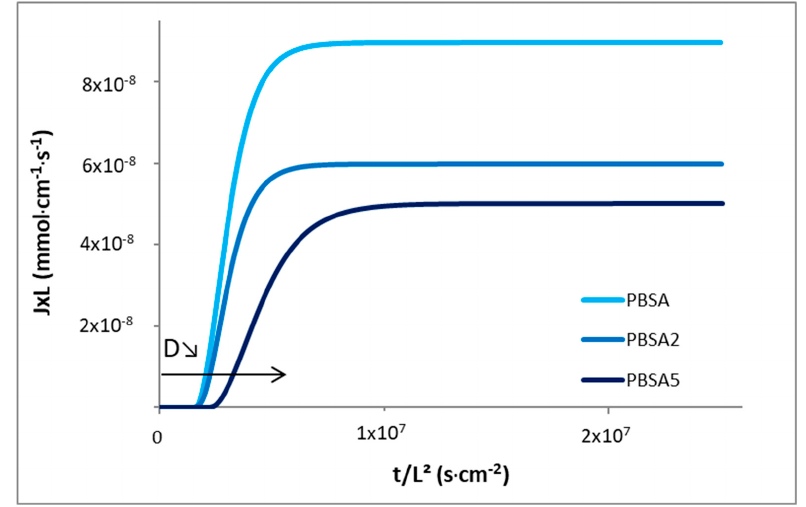
Figure 4. Reduced water permeation curves for the neat PBSA and the filled PBSA films.